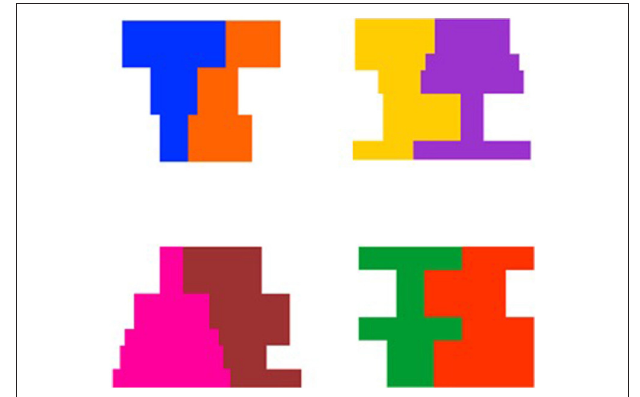
FIGURE 1 | Examples of the 4 shape composites and 4 color pairs used in Experiments 1 and 2 .